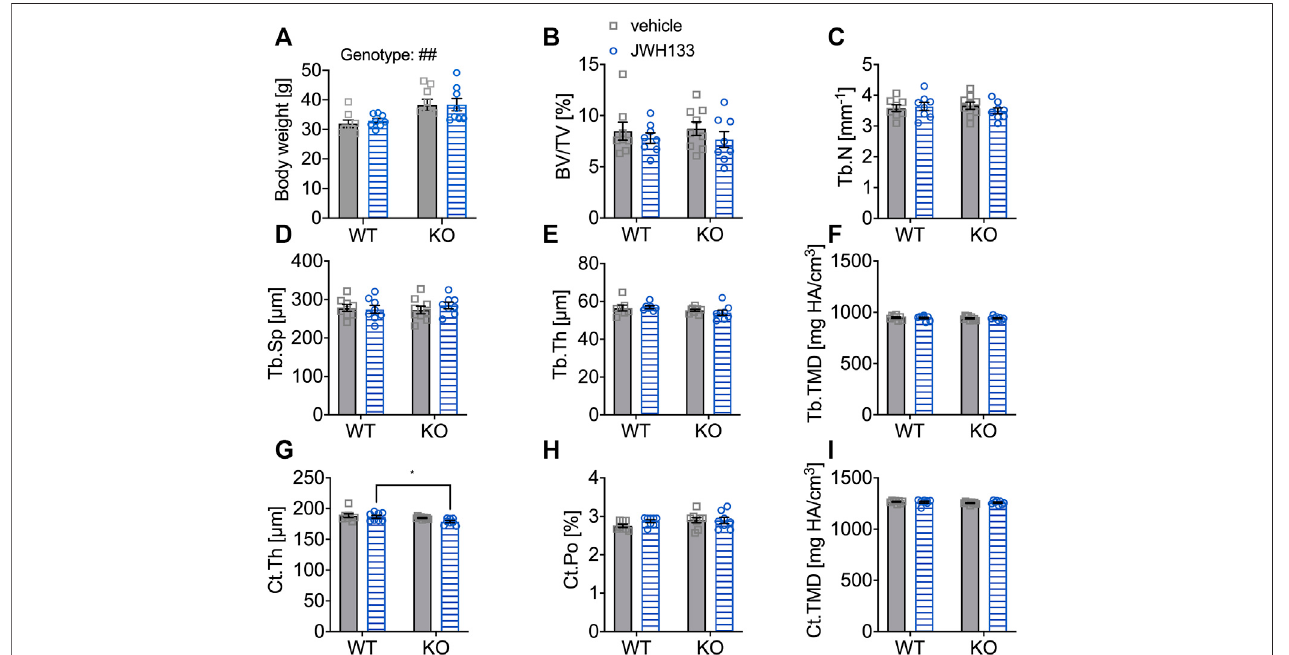
FIGURE 6 | Aged mice did not respond with detectable changes in femoral trabecular and cortical bone ( μ CT) after a prolonged treatment duration with JWH133. (A) Male mice were aged 6 months by the beginning of the experiment. Body weight of p62 KO animals was signi fi cantly increased compared to WT mice at the beginning of the experiment. (B) Bone volume per tissue volume (BV/TV) was similar between WT and p62 KO mice and showed no effect of treatment. (C) Trabecular number (Tb.N) was comparable between genotypes without an effect of treatment. (D) Trabecular spacing (Tb.Sp) showed no difference between genotype or treatment. (E) Trabecular thickness (Tb.Th) was comparable for genotype and treatment. (F) Tissue mineral density (TMD) of the femur was not in fl uenced by the treatmentand showedno difference between genotypes. (G) Corticalthickness (Ct.Th)waslowerin p62KO mice leadingtoasigni fi canteffect ofgenotype. (H) Cortical porosity (Ct.Po) and (I) tissue mineral density (Ct.TMD) of cortical bone were similar between genotypes and not in fl uenced by the treatment with JWH133. Data were analyzedbyusing ordinary two-way ANOVA and Bonferroniadjusted p values, * p < 0.05, ** p < 0.01, *** p < 0.001. All errorbars showmean± SEM. Squares and circles represent individual data points. WT vehicle N = 8, KO vehicle N = 9, WT JWH133 N = 8, KO JWH133 N =